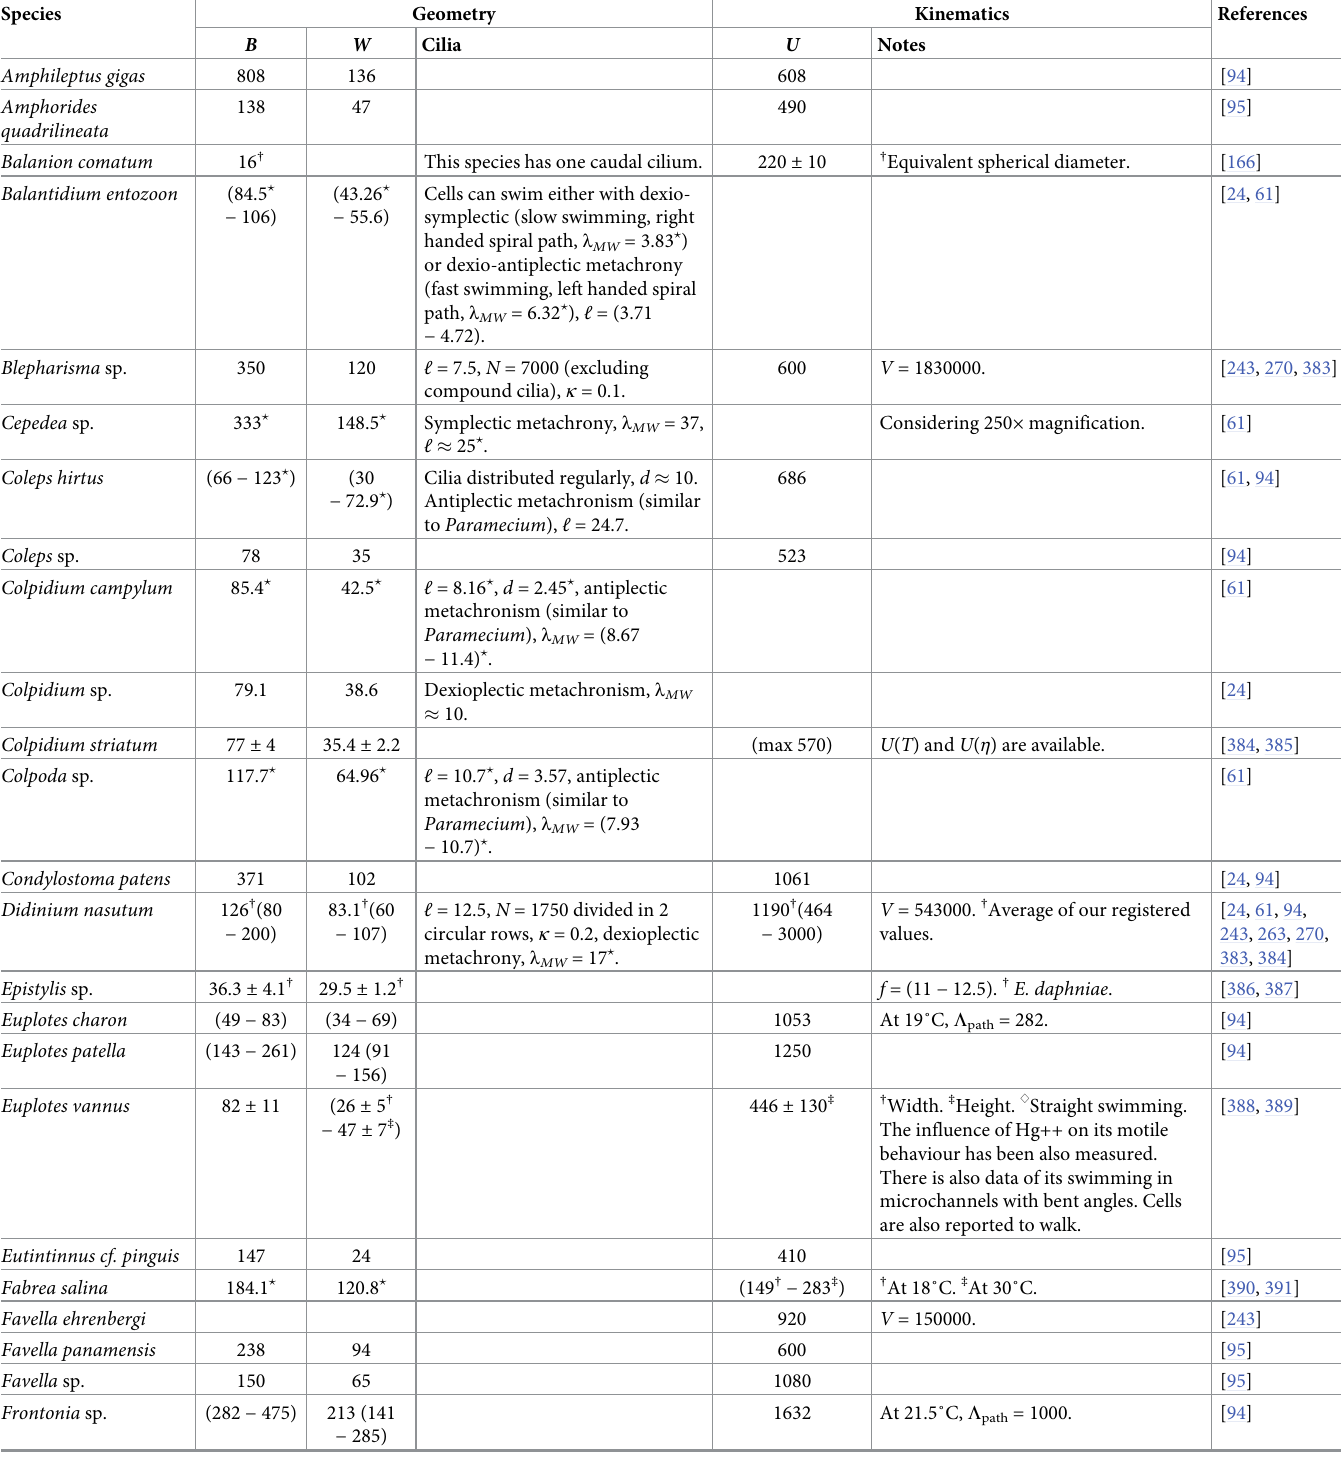
Table 9. Data for ciliates.